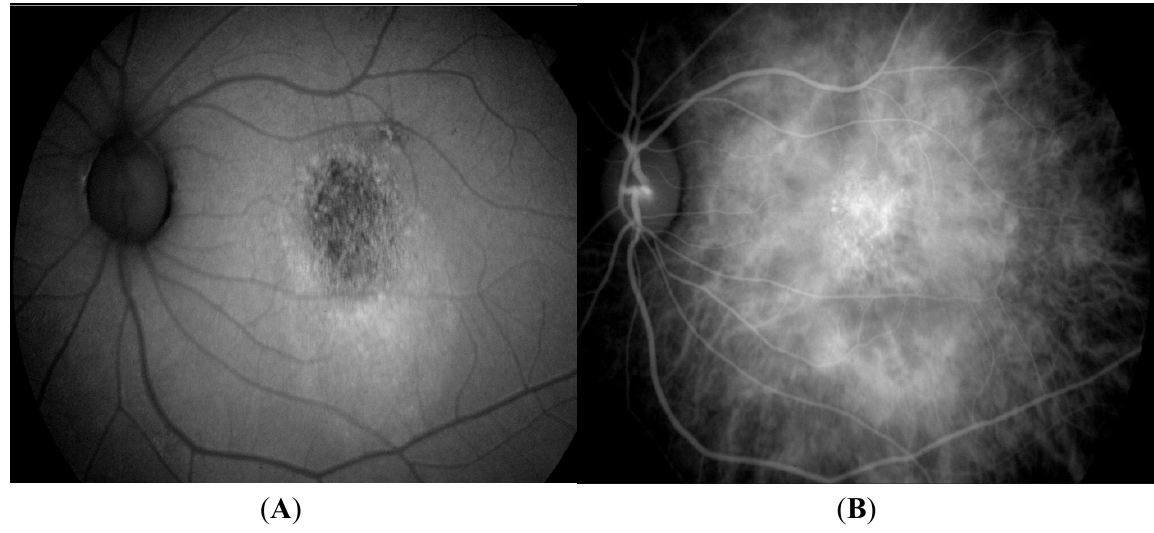
Figure 3. Fundal autoflorescence image ( A ) showing granular hypoautofluorescence, which corresponds to the abnormal branching vascular network seen on indocyanine green angiography ( B